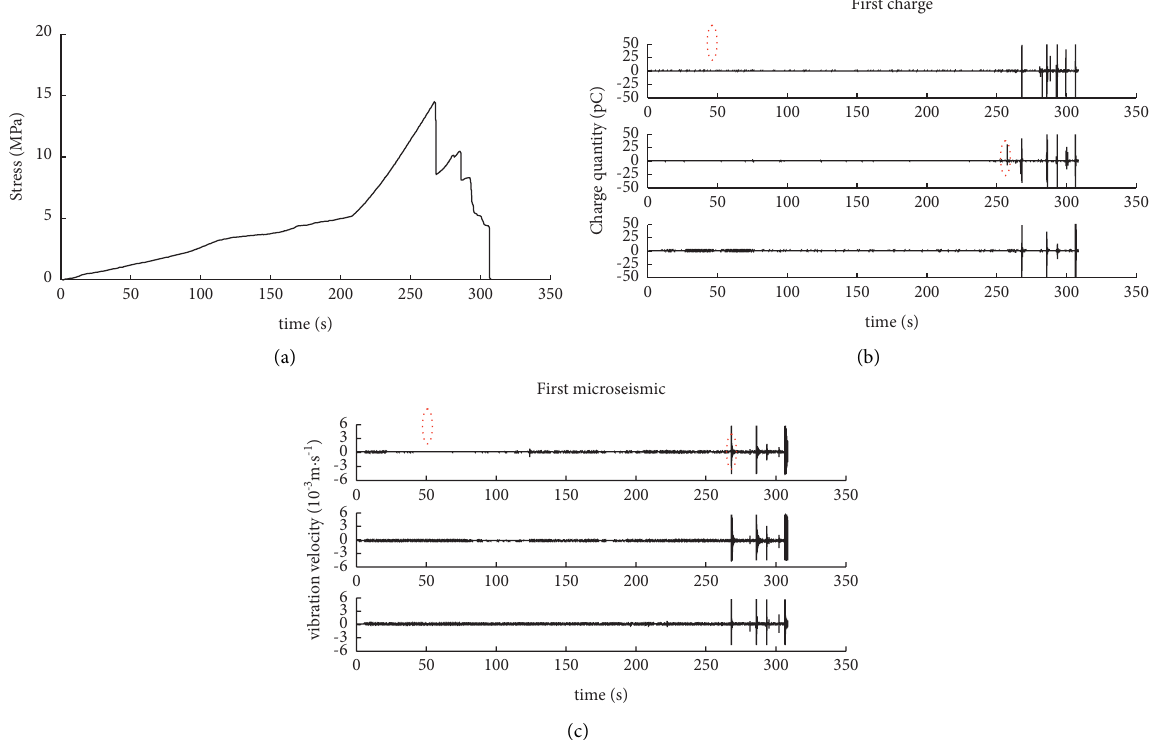
Figure 7: Charge induction and microseismic signals of coal when loading rate is 0.01 mm/s. (a) Stress curves. (b) Charge induction signals curves. (c) Microseismic signals